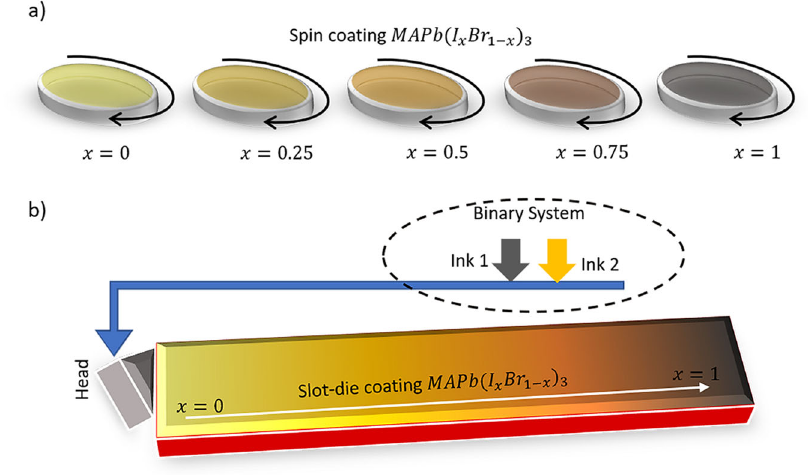
Fig. 1 Schematic of approaches for material composition optimization. a Conventional approach to fabricate a limited number of compositions. b Fabrication of compositionally-graded fi lms (CGFs) that include all possible phases from binary systems in one